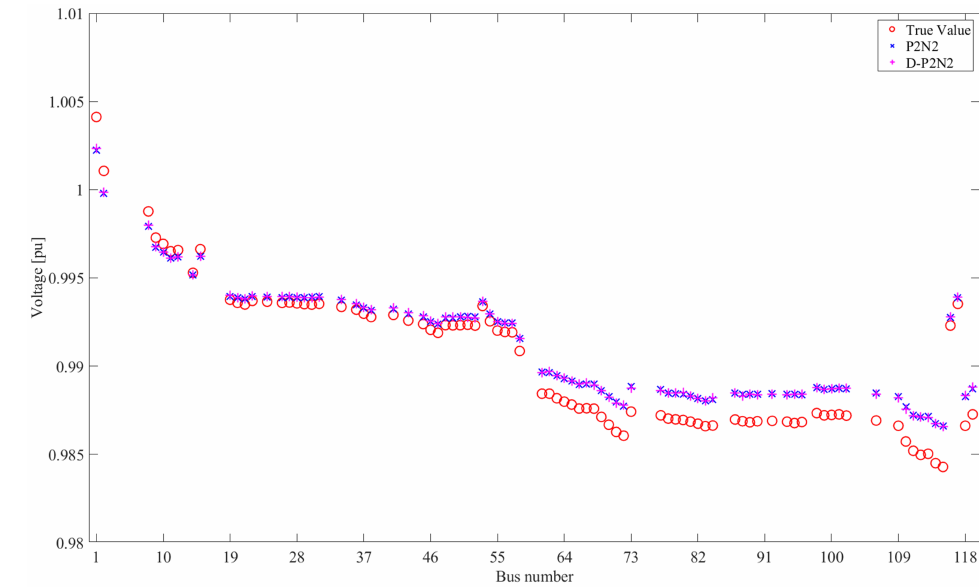
Figure 11. Estimated voltage magnitude at Phase A in Scenario 3.